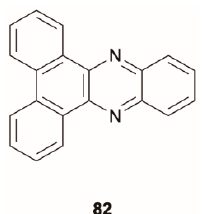
Figure 20. ( a ) Absorption and emission spectra of 82 in THF solution at 298 and 78 K. The insets are the photos of the steady-state emission. The excitation wavelength is 390 nm. ( b ) Natural transition orbital (NTO) images of the S 1 , S 2 , T 1 and T 2 excited states of 82 . The NTO images of each excited state represent their transition forms from the “hole” unity to the “particle” unity, respectively, and the percentages on the arrows are the proportions of the transitions. ( c ) Schematic Jablonski diagram with SOC matrix elements of RTP-related ISC processes in 82 . Adapted with permission from [76]. Peng et al. [78] investigated the photophysical properties in different states of a series of amino benzothiadiazoles. Anti-Kasha dual emission was observed in solution for 83 –